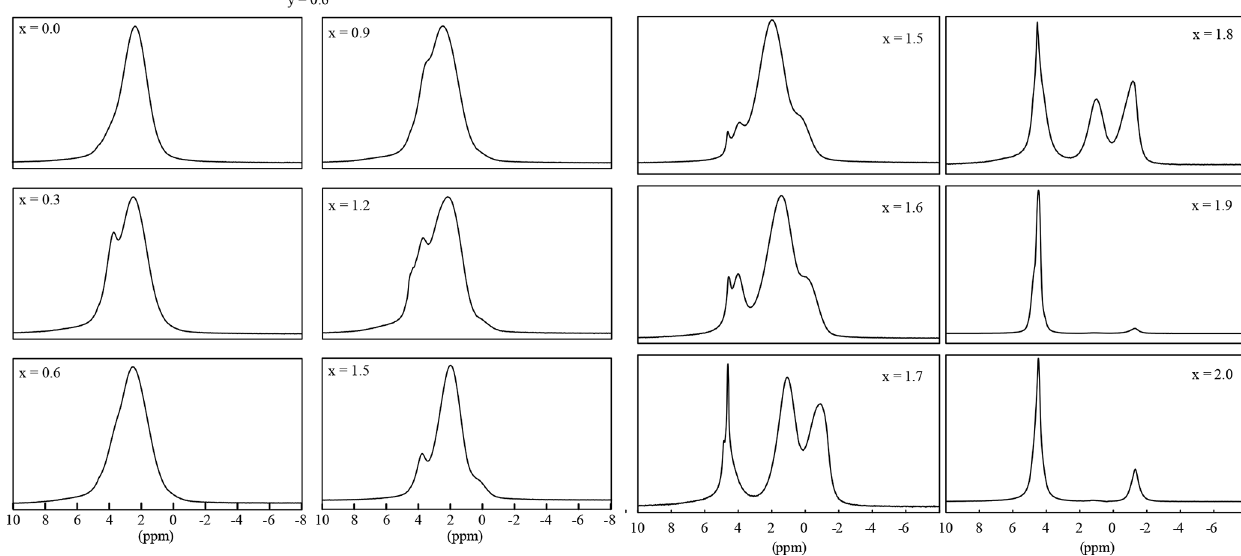
Figure 9. 1 H MAS NMR spectra of samples with 0.0 ≤ x ≤ 1 . 2, y = 0 . 6 (left two rows) and 1 . 5 ≤ x ≤ 2 . 0), and y = 1 . 2 (right two rows).